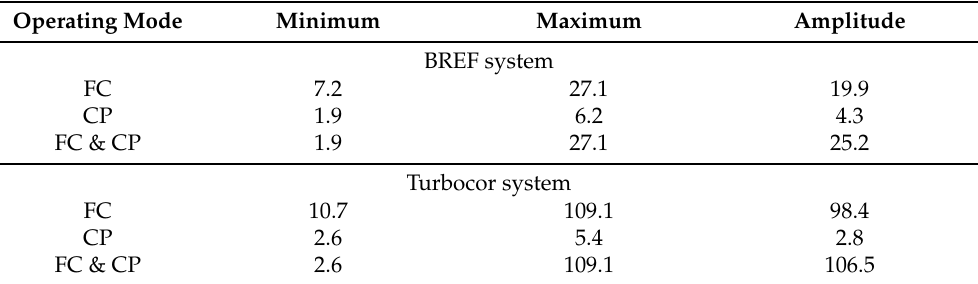
Table 4. Momentary COP profile parameters of cooling systems by operating